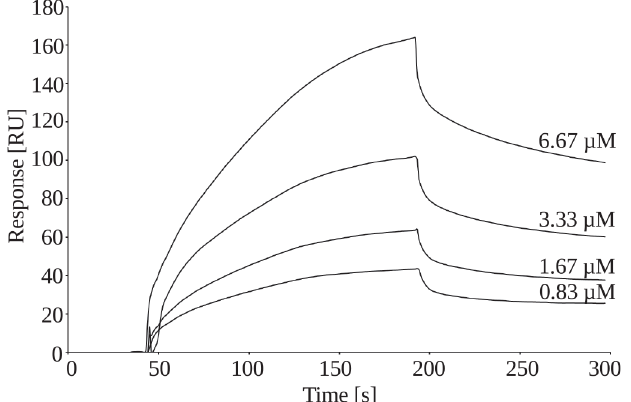
Fig 6. SPR analysis of IgG binding to recombinant ficolin-3. Ficolin-3 was immobilized on a CM5 chip. Ficolin-3 concentrations are indicated adjacent to sensorgrams. RU, resonance